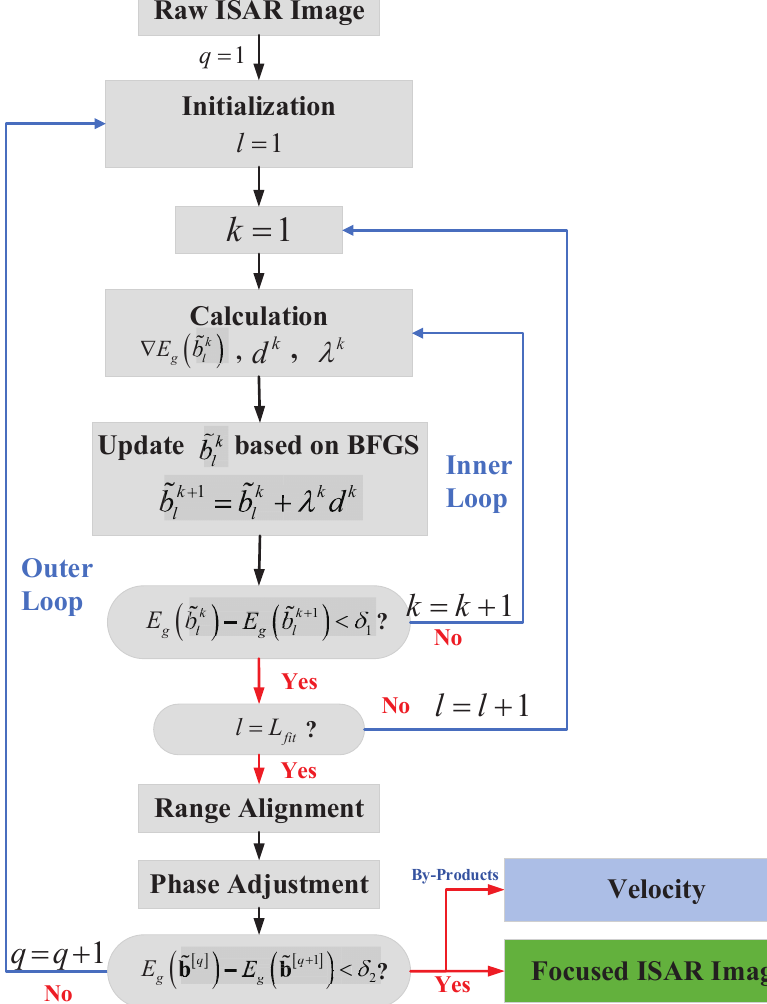
Figure 4. The flow chart of the proposed